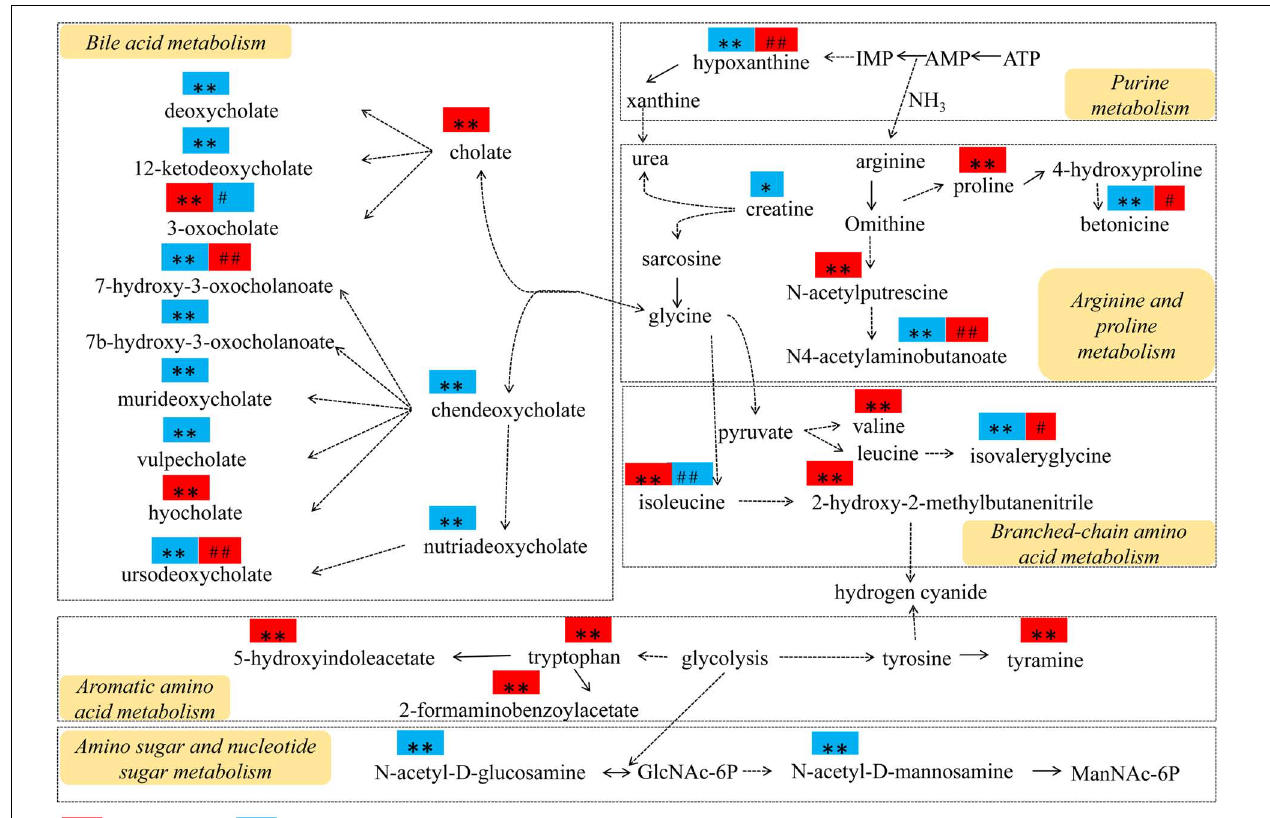
FIGURE 6 | Comprehensive metabolic network of the metabolites and the major metabolic pathways in rats with antibiotic-induced gut microbiota dysbiosis.